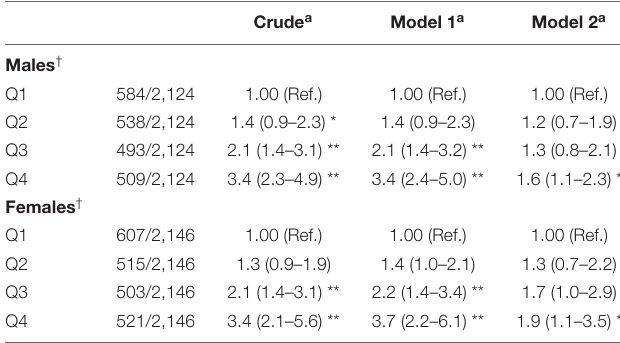
TABLE 9 | Weighted odds ratios (95% confidence intervals) for insulin resistance (HOMA-IR) of participants without metabolic syndrome across quartiles of serum uric acid (Men = 2,124, Women =